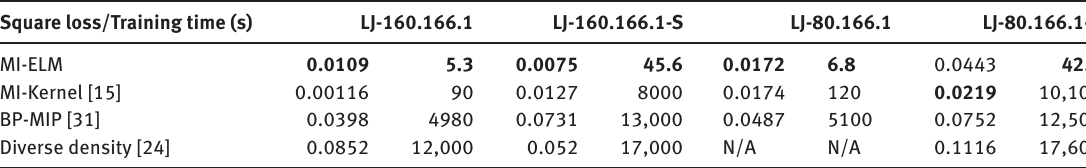
Table 6: Square Loss and Training Time on Regression Data